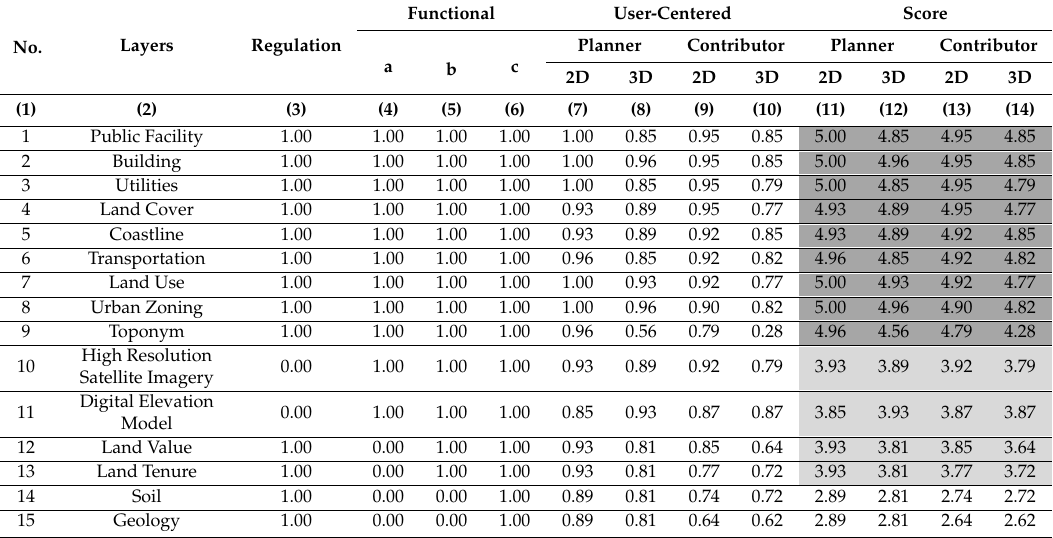
Table 1. Score from three chains: regulation, functional, and user-centered requirements.